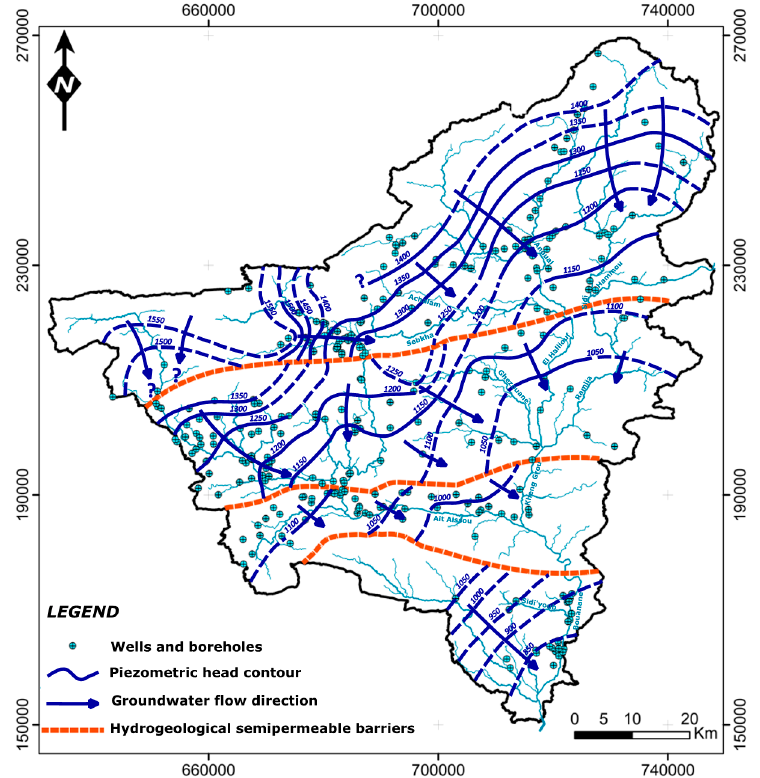
Figure 10. Piezometric map of the Upper Guir groundwater drawn using data from the current study (40 data) and from the archives of the water agency, ABHGZR (250 data).